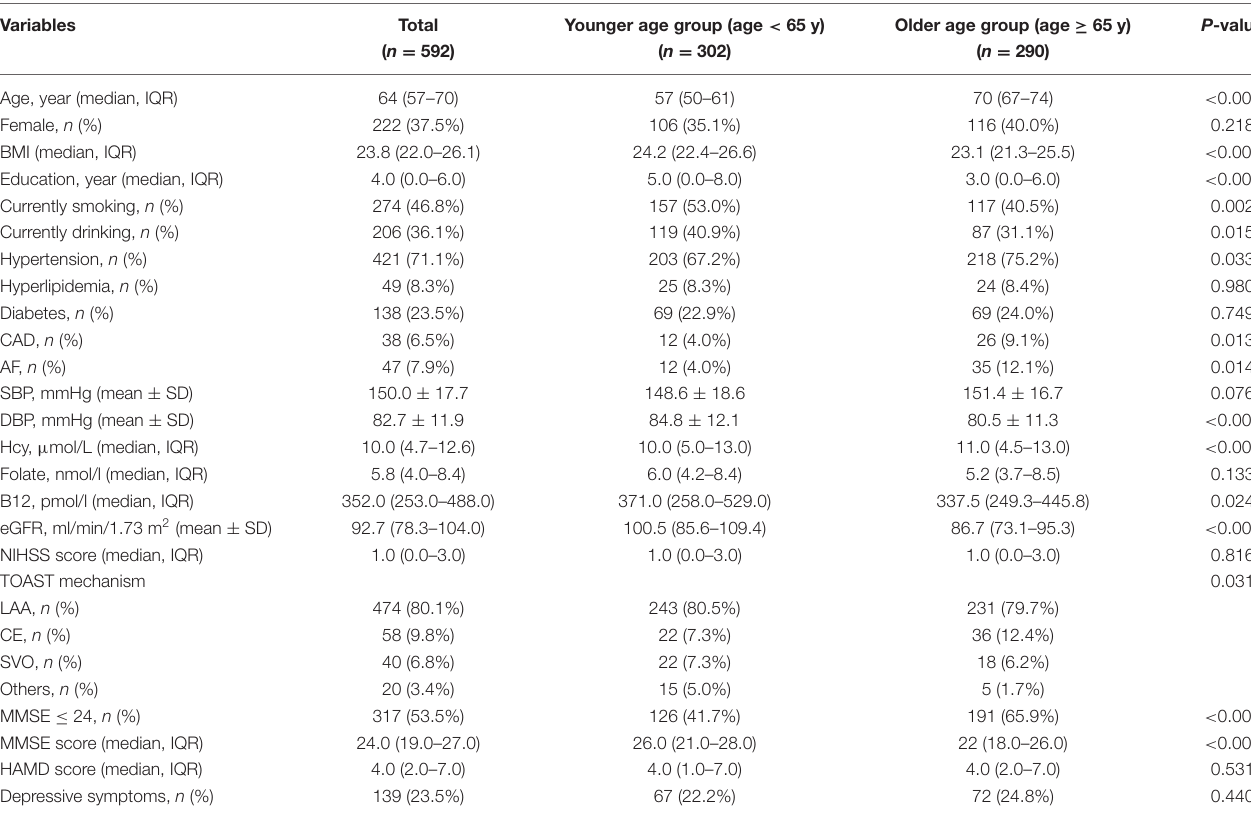
TABLE 4 | Baseline characteristics of patients with AIS grouped by age. Variables